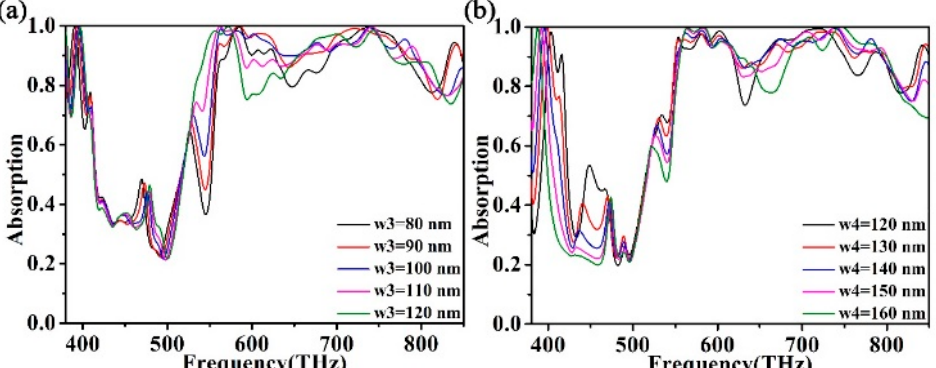
Figure 5. ( a ) The effect of square ring spacing W3 on the absorption spectrum. ( b ) The effect of cross-width W4 on the absorption spectrum.